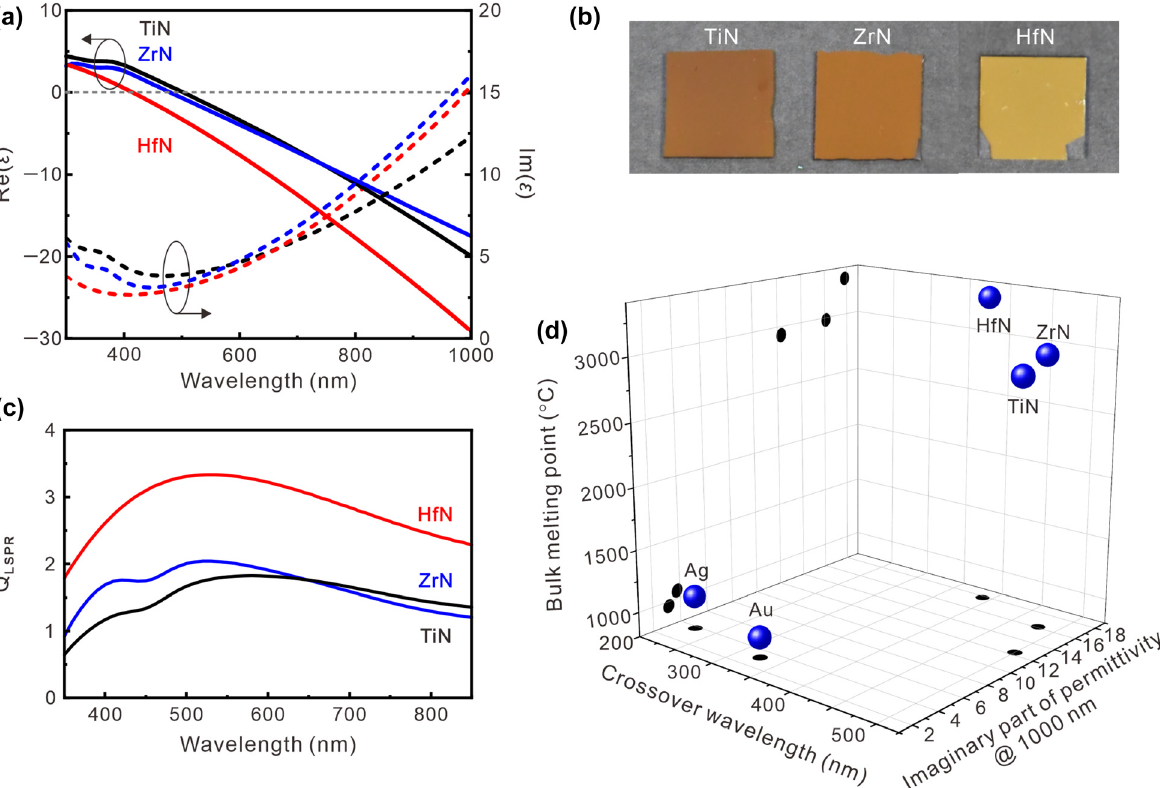
Figure 1: Material characterization of plasmonic transition metal nitride films. (a) Real part (solid line) and imaginary part (dashed line) of the dielectric permittivity of the fabricated plasmonic TiN (black), ZrN (blue), and HfN (red) films. (b) Image of TiN, ZrN, and HfN films on sapphire substrates deposited by RF reactive magnetron sputtering in an ultrahigh- vacuum chamber at 800 ° C. (c) Calculated quality factor of the LSPR from the TiN, ZrN, and HfN fi lms. The relatively high quality factor of the LSPR in the HfN fi lms can cover the entire visible spectrum. (d) TiN, ZrN, and HfN provide a relatively high-quality plasmonic resonance in the visible region and refractory properties that can survive under harsh operational